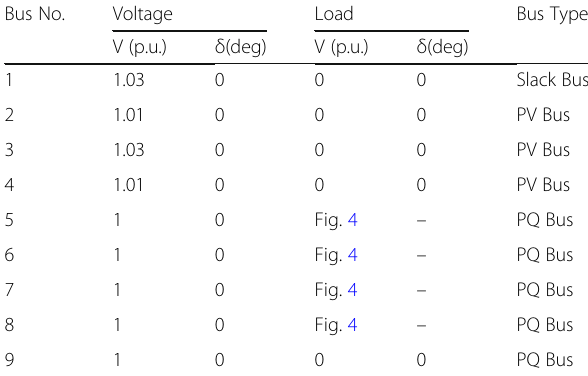
Table 2 Bus information of the example system Bus No.